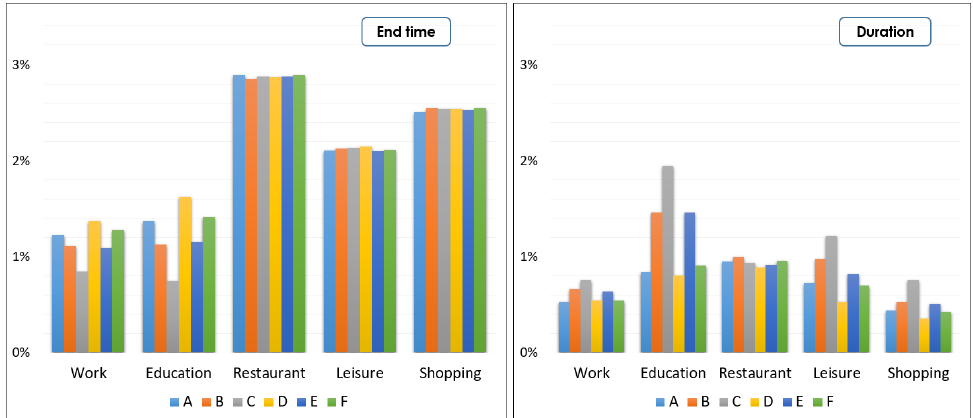
Figure 26. Comparison of time estimation error of the different configurations. ( Left ): at the end- time level, the configurations have almost the same activity-error value for restaurant, leisure, and shopping; the differences are at work and education activities, with an advantage belonging to (C), then to (E) and (B). ( Right ): at the duration-level, larger differences appear; configuration (D) is better than the others, followed by (A), (F), and (E). A compromise has to be made on these two criteria: configuration (E) shows the best trade-off between duration and